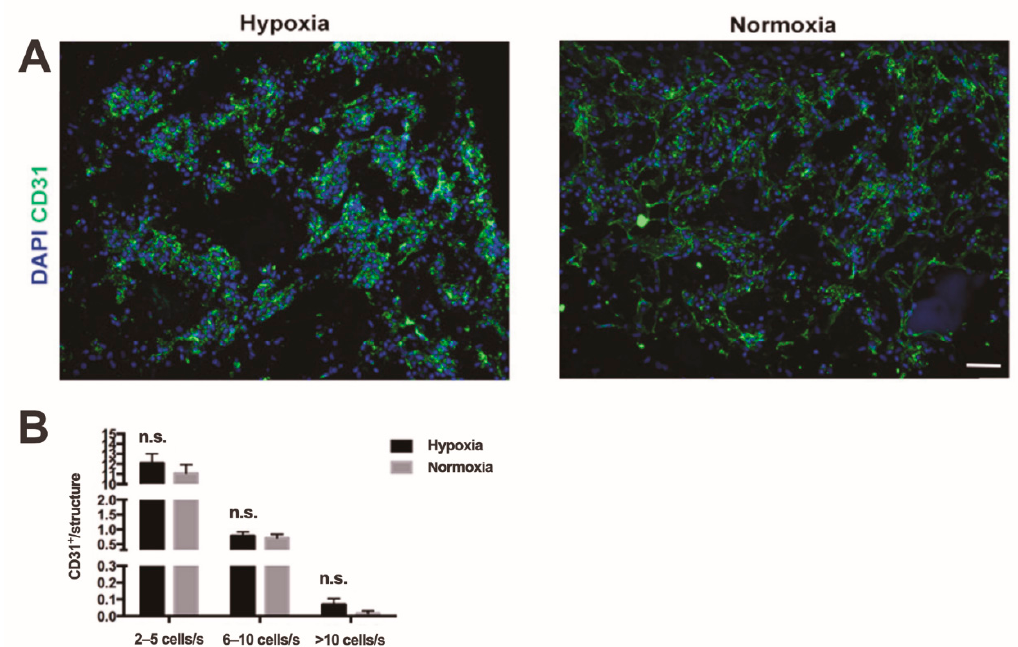
Figure 3. In vitro endothelial cell organization. ( A ) Immunofluorescence staining endothelial cell marker (CD31, green) of constructs with SVF cells cultured in hypoxia and in normoxic culture. Cell nuclei were stained with DAPI (blue). Scale bar = 70 µm. ( B ) Quantification of number of organized endothelial cells in small (3–5 cells per structure), middle ‐ size (5–10 cells per structure), and complex (over 10 cells per structure) cord ‐ like structures. n.s. = not statistically significant; s: structure; n = 72 (6 donors). Comparison was performed with non ‐ parametric test (Mann–Whitney ‐ U).